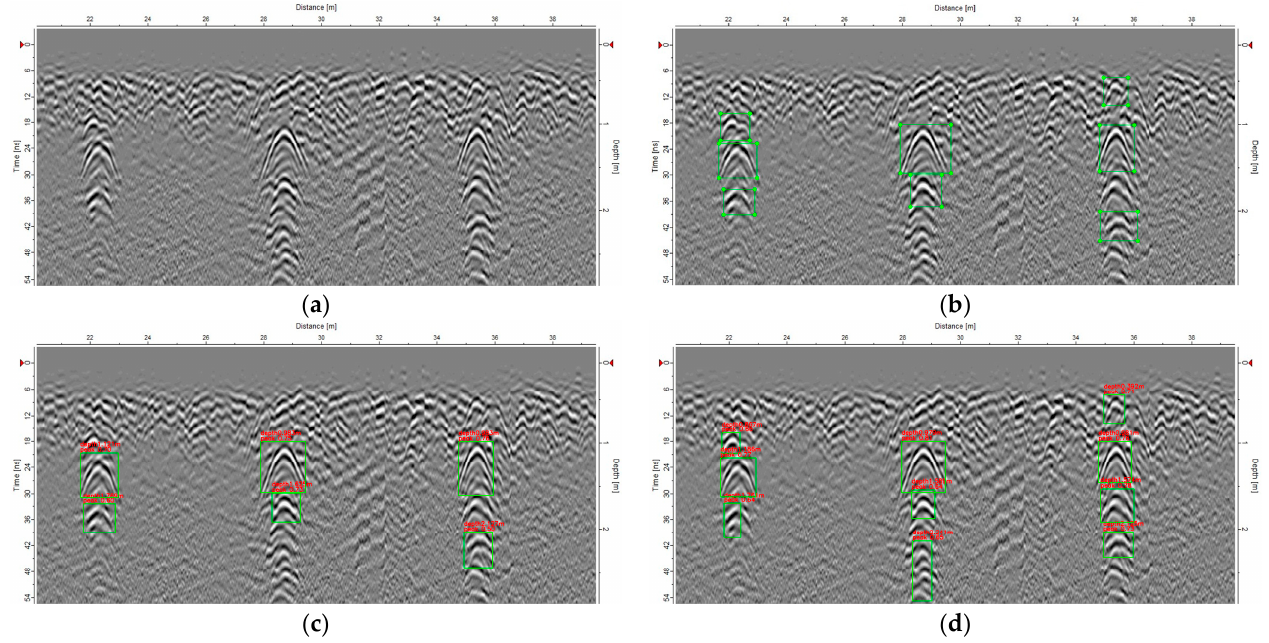
Figure 25. ( a ) Original image; ( b ) foreign objects expected to be detected; ( c ) foreign objects detected by the YOLOv5 algorithm; ( d ) foreign objects detected by the improved YOLOv5 algorithm.